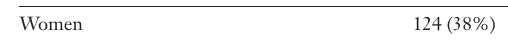
Characteristics of the 330 patients trained for patient self-man- agement of oral anti- coagulant therapy (PSM).